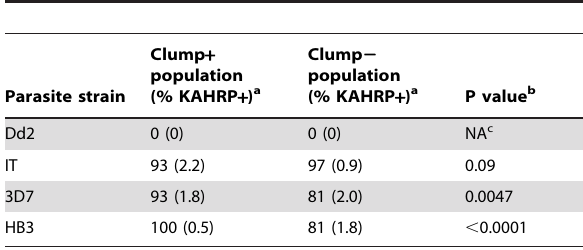
a The percentage of infected erythrocytes expressing the Knob-Associated Histidine Rich Protein (KAHRP) was assessed by fixed cell IFA with mAb 89 to KAHRP. 100 cells in four separate areas of the slide were assessed for staining, and the mean (standard error) of the percentage of positive cells from the four counts are shown. b Paired t